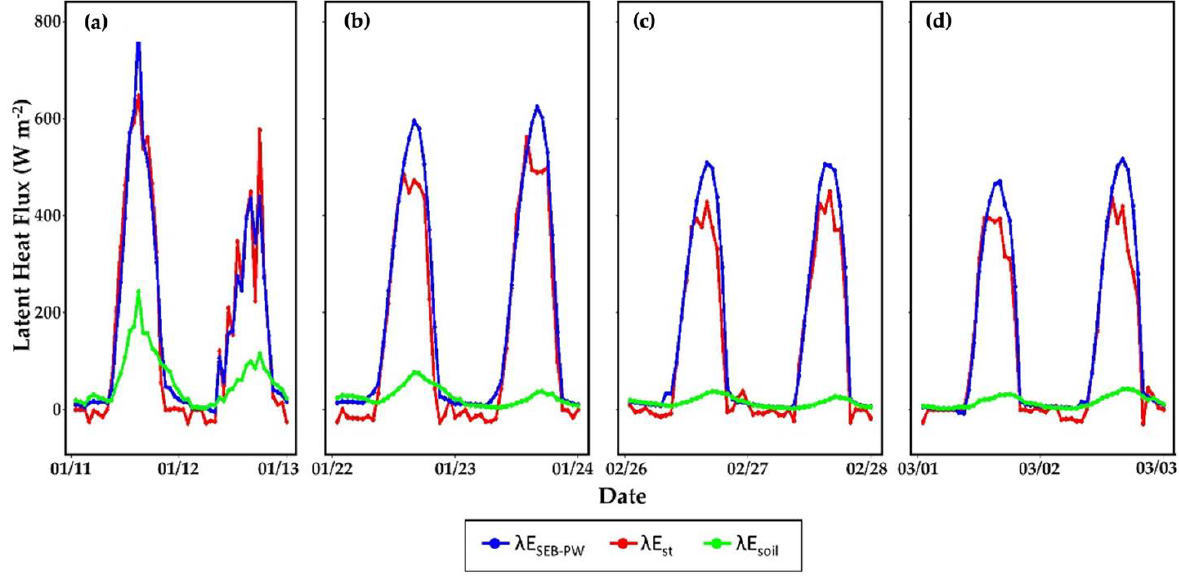
Figure 8. ET and E estimated by the SEB –PW model (λE SEB-PW and λE soil ) and ET measured by the ET station (λE st ) during four field campaigns ( a – d ) at site S2 in 2019.